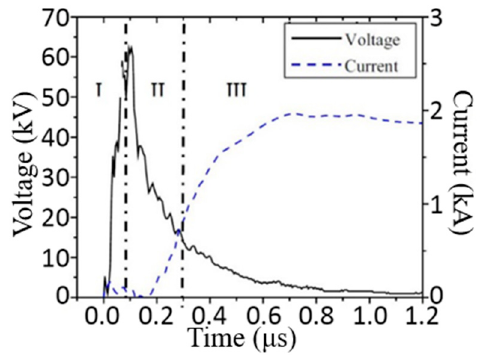
Figure 2. Relationship between breakdown field strength and voltage rise time of different dielec- trics [12].